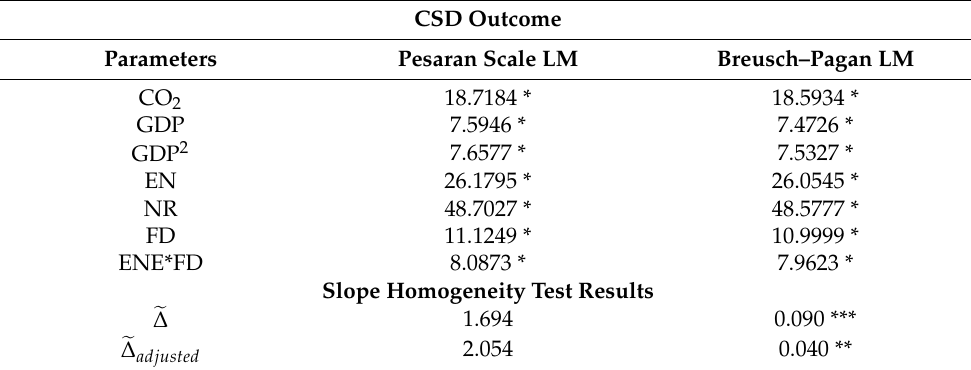
Table 2. Outcome of CSD test and Slope homogeneity test.